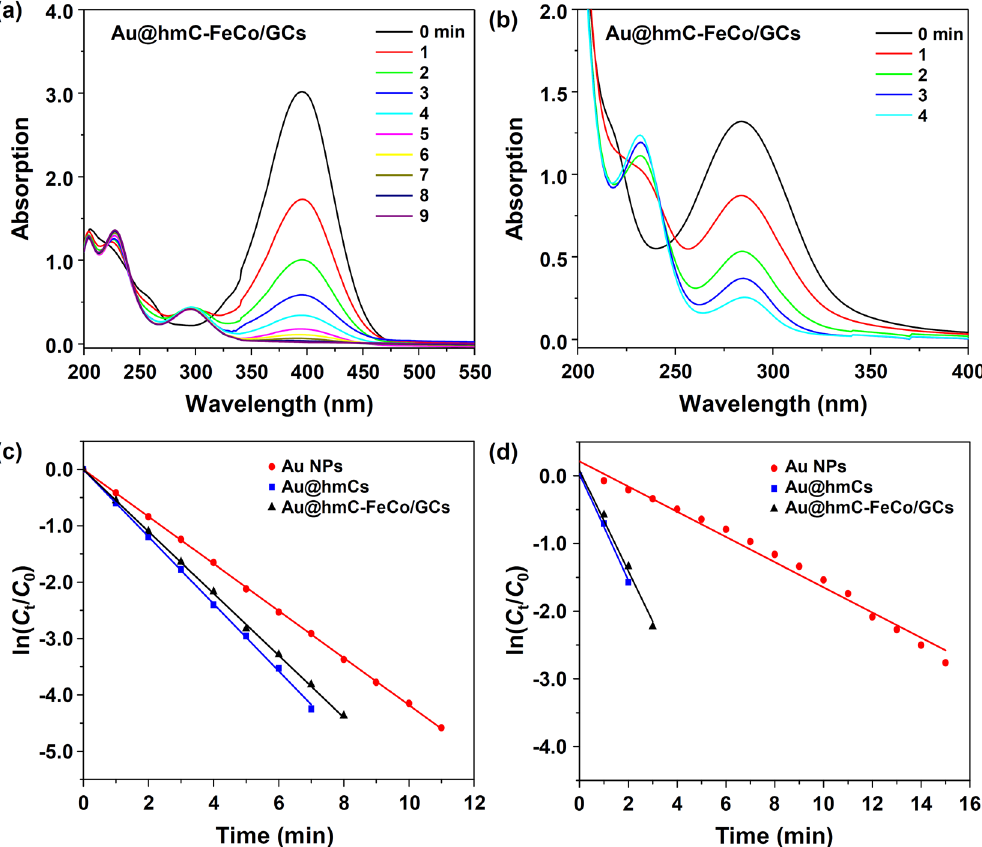
Figure 6. ( a , b ) Time-dependent UV-vis spectral changes of the reaction mixture catalysed by Au@hmC- FeCo/GCs for 4-nitrophenol ( a ) and 4-nitrotoluene ( b ). ( c , d ) Plot of ln ( C 0 / C t ) versus reaction time for each nanocatalyst for the reduction reactions of 4-nitrophenol ( c ) and 4-nitrotoluene ( d